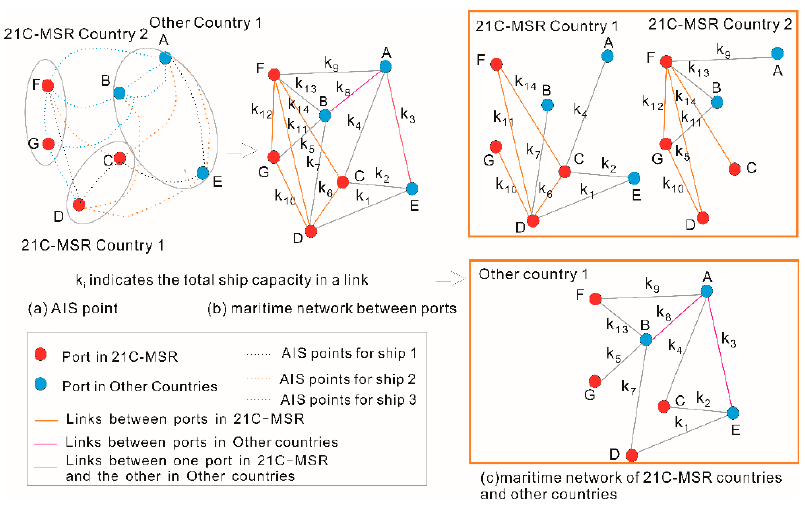
Figure 1. Proposed analytical framework.